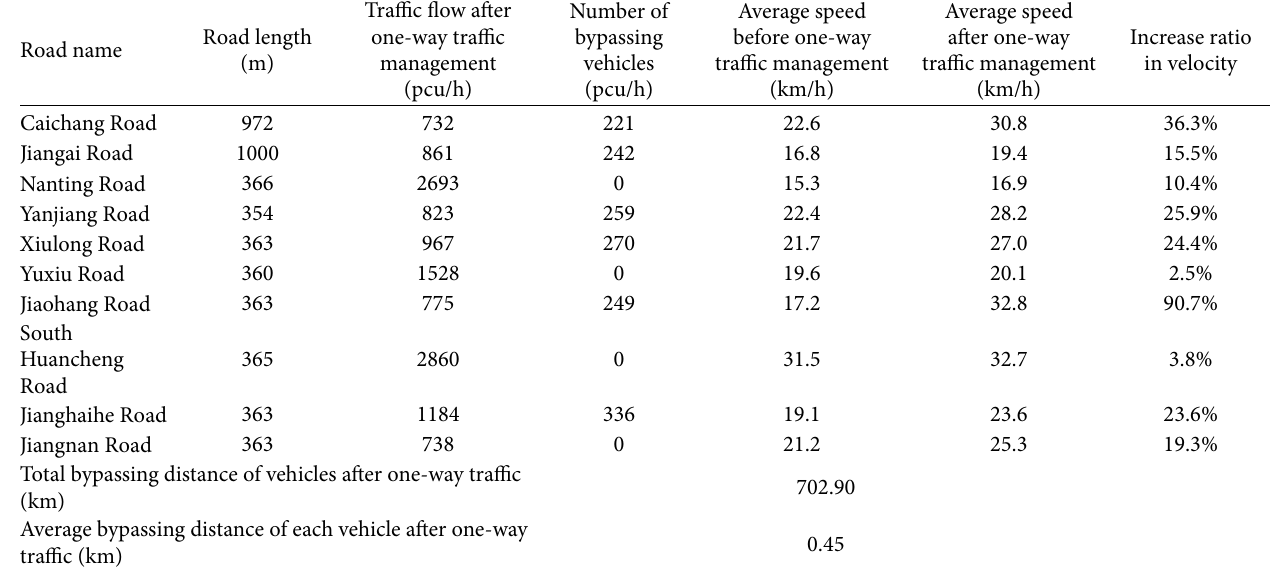
Table 6: Bypassing vehicles and speed in the road sections before and after one-way traffic management.